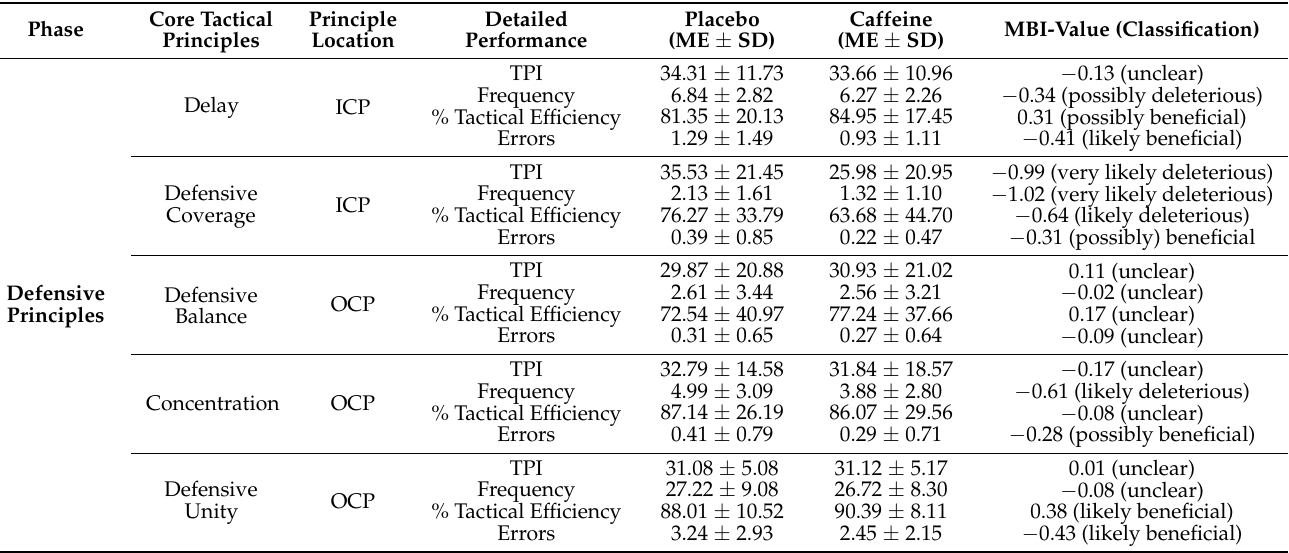
Table 3. Results of the core tactical principles of soccer featuring defensive